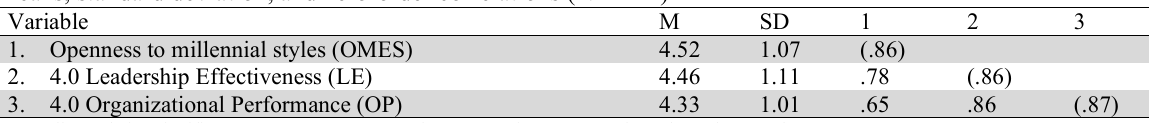
Means, standard deviation, and zero-order correlations (N = 224)